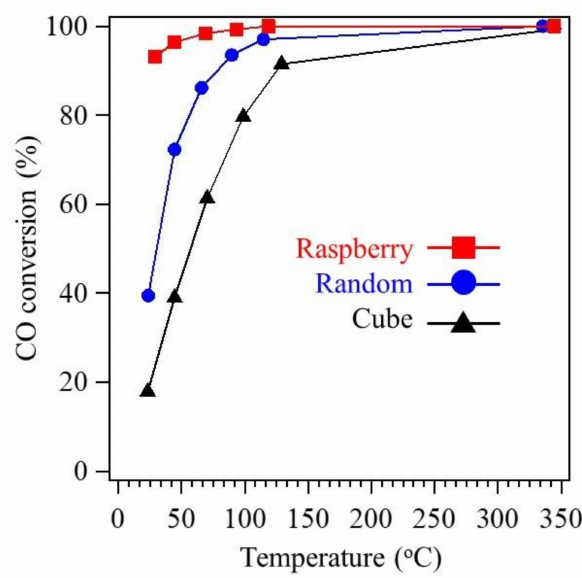
Figure 6. CO conversion efficiency measured with decreasing temperature in the range of 25–350 ◦ C for randomly shaped (blue circles), cube-like (black triangles), and raspberry-shaped (red squares) Co 3 O 4